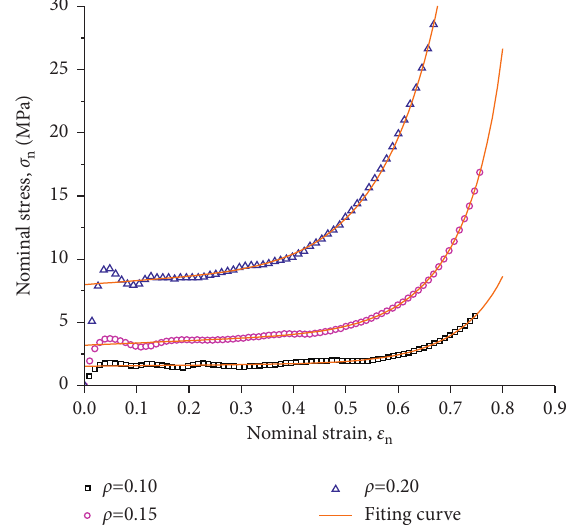
Figure 5: Uniaxial compression curve fitting of the Hanssen model.